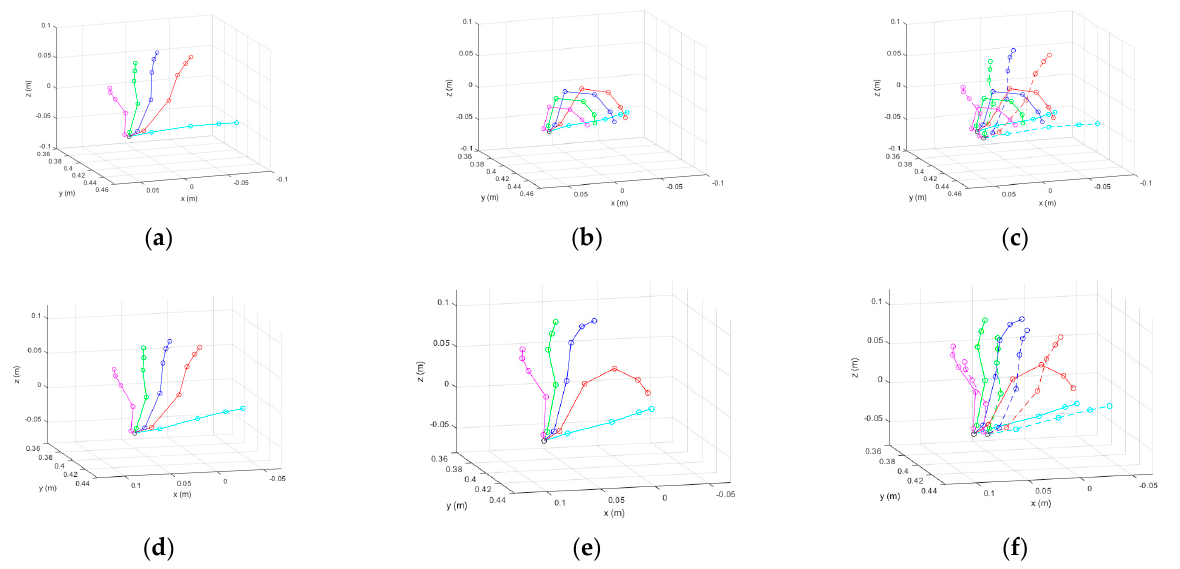
Figure 2. Joint trajectories with respect to grab and pinch gestures (right hand): ( a ) grab (at start); ( b ) grab (at end); ( c ) grab (combined ( a , b )); ( d ) pinch (at start); ( e ) pinch (at end); ( f ) pinch (combined ( d , e )).